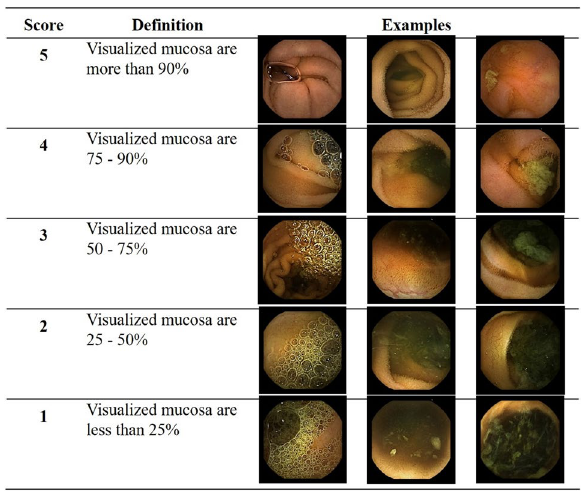
Figure 2. Cleansing score used for deep learning: a 5-step scoring method based on the proportion of visualized mucosa.